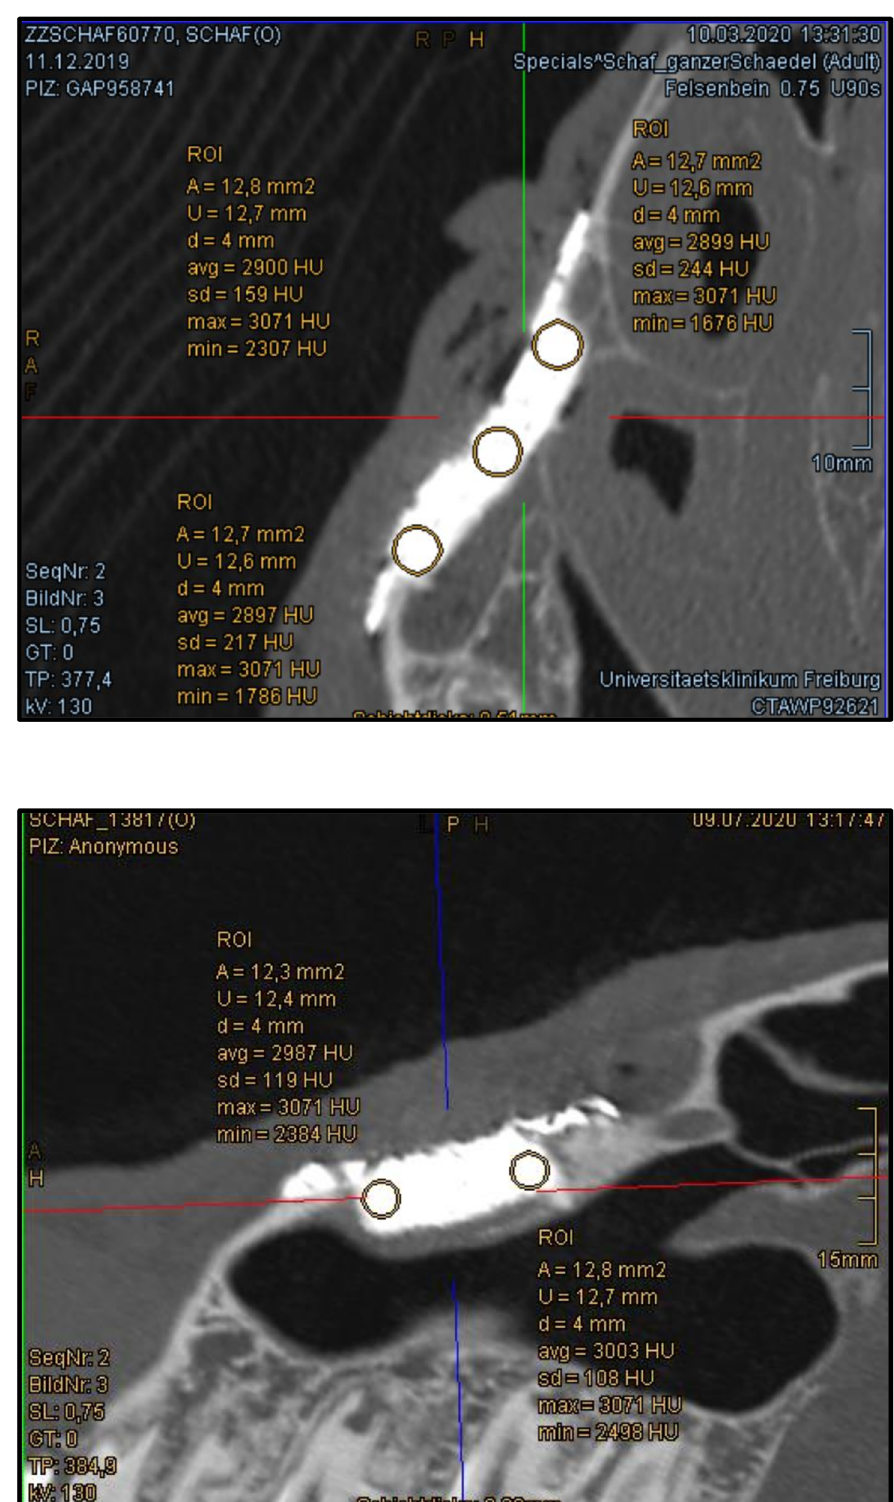
Fig. 7 Exemplary images of the spots used for investigation of density analysis. Four spots were positioned at the border of the scaffold, one was placed in the middle of the